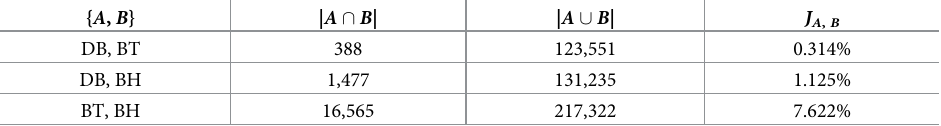
Table 3. Jaccard similarity index values representing the pairwise comparison results of the same bots detected between each bot detection platform: Botometer (BT), Bot-hunter (BH) and DeBot